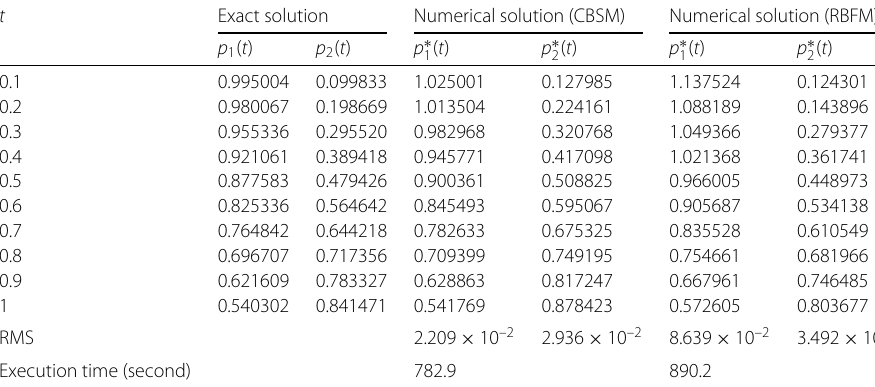
Table 2 Numerical solutions of Example 5.2 with α =